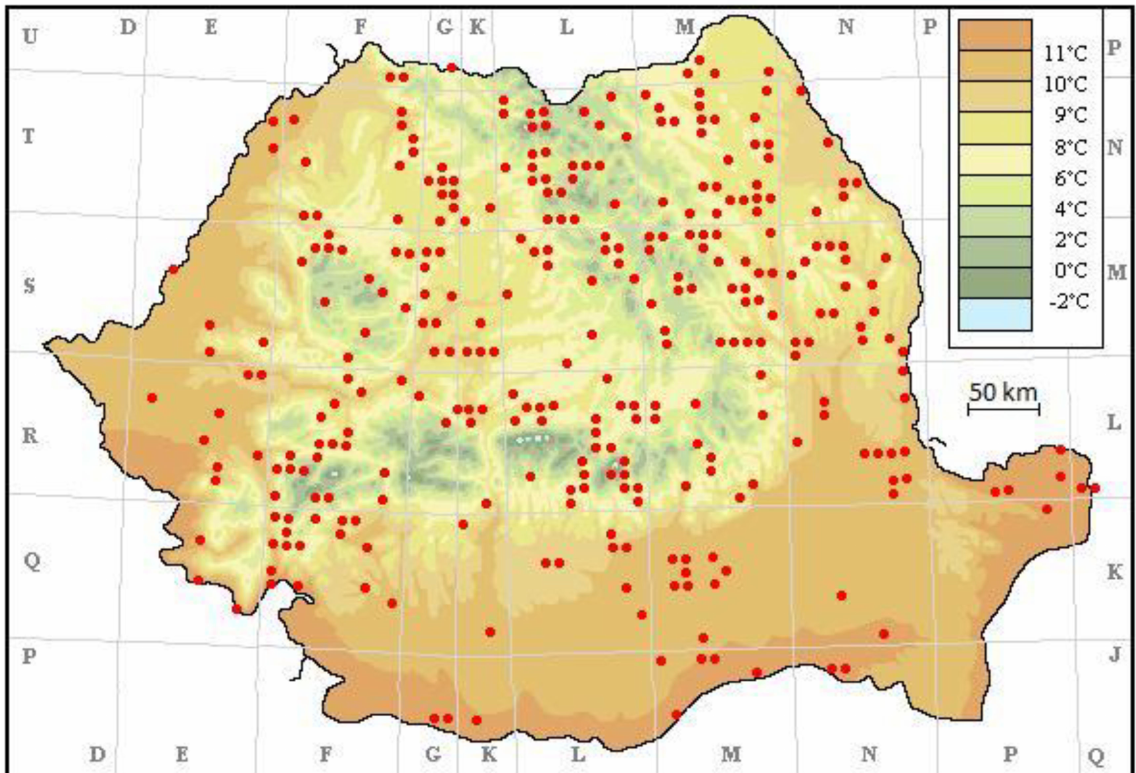
Figure 4. Distribution of Figure 3. Distribution of Salix alba communities. Salix fragilis communities.